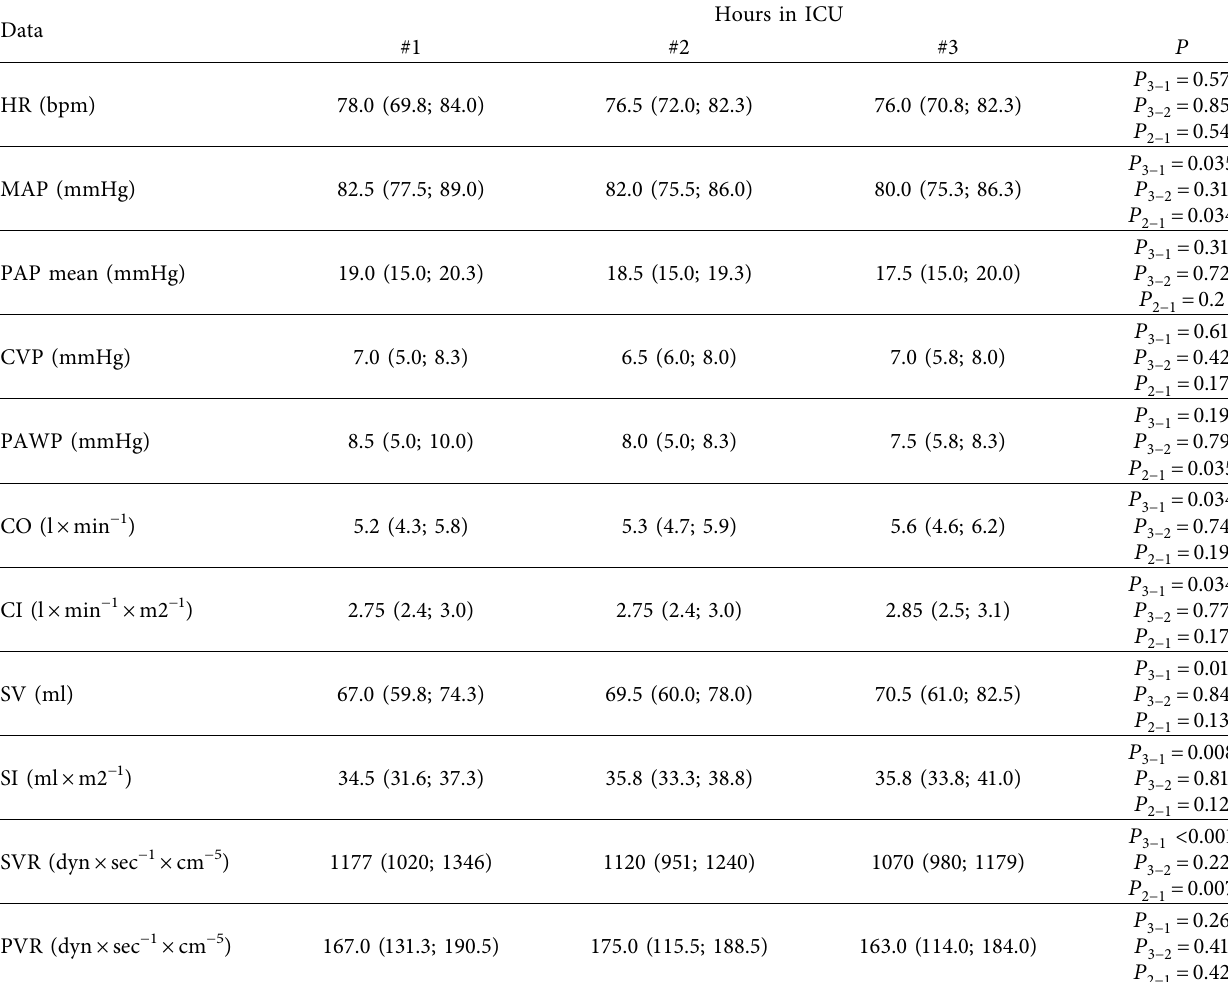
Table 6: Changes in hemodynamic profile in patients from the control group, median (25 th ; 75 th percentile), n � 24.